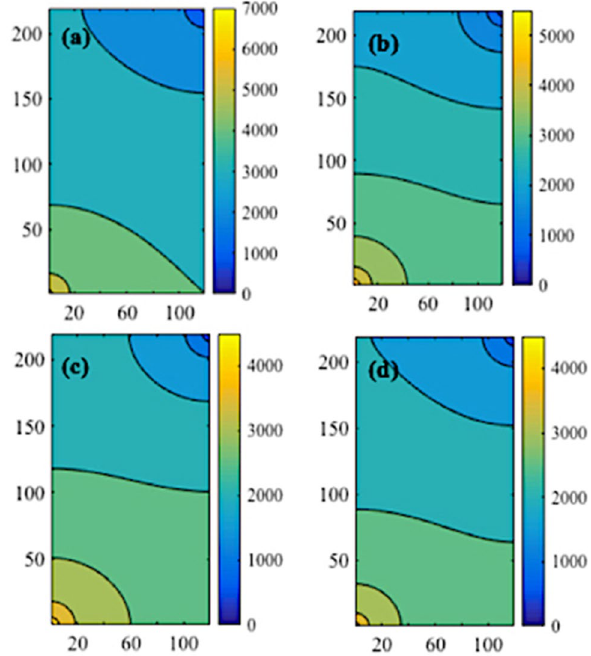
Fig. 3 Voltage distribution (in volts) in the reservoir at: a 250 days, b 500 days, c 750 days, and d 1000 days (injection well at the lower left corner; production well at the upper right